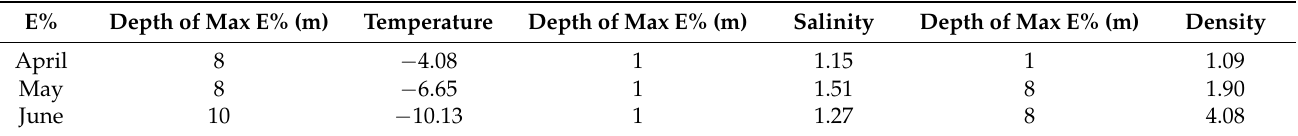
Figure 10. Percentage error along the water column between T ( a ), S ( b ) and ρ ( c ) simulated by the CROM model and observed at the LTER ‐ MC sampling site for April, May and June 2016. Table 10. Maximum error difference between observed and simulated hydrological data. Figure 9. Monthly mean vertical profiles of T ( a ), S ( b ) and ρ ( c ) at LTER ‐ MC sampling site for April (red line), May (blue line) and June (black line) 2016. Dashed lines are the simulated vertical profiles over 37 grid point of Figure 8l.